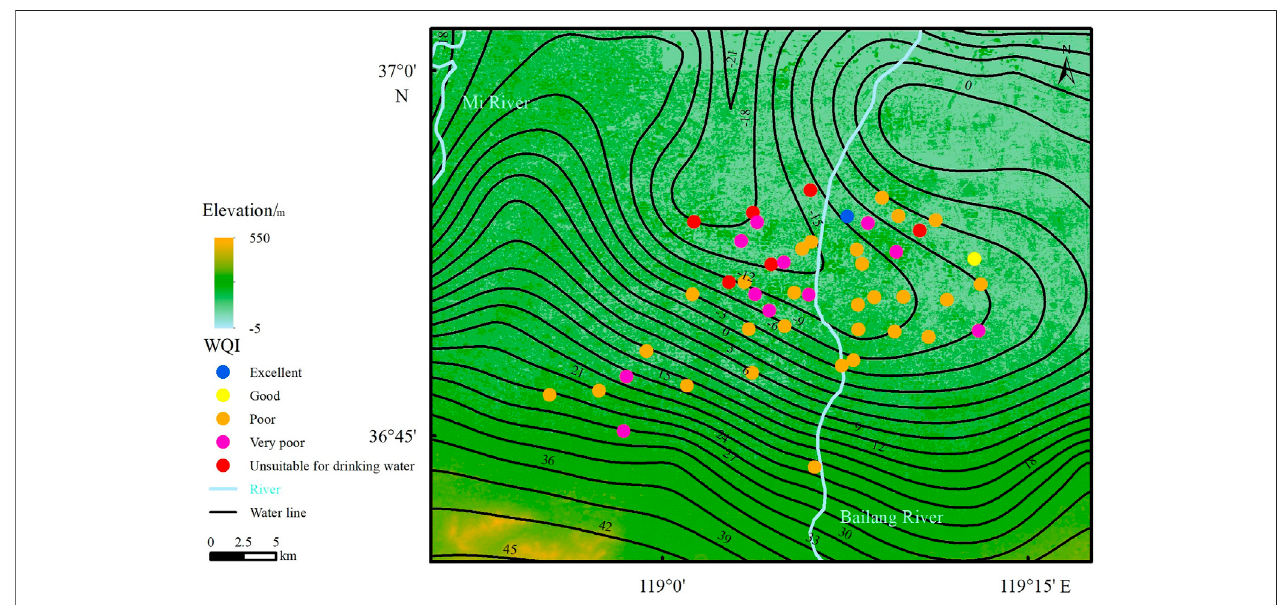
FIGURE 8 | The distribution of groundwater quality index